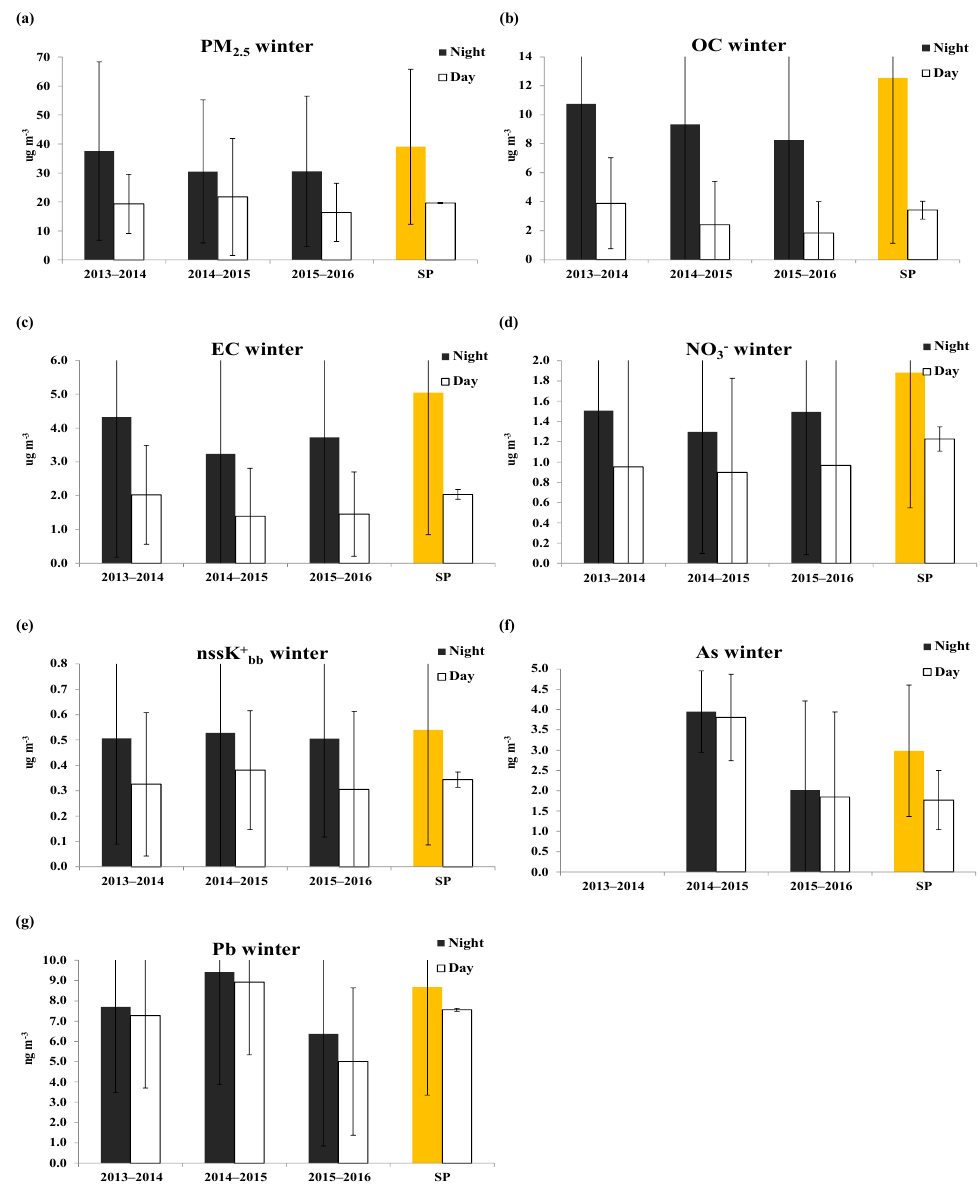
Figure 6. Winter PM 2 . 5 mass, OC, EC, NO − concentrations when only smog events